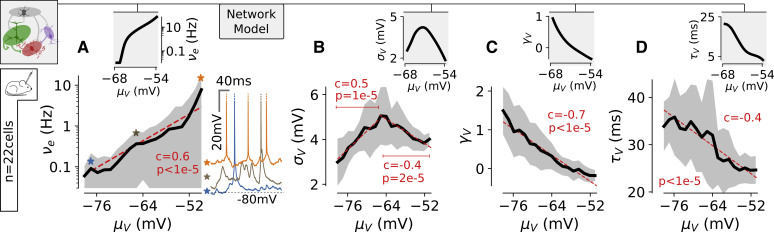
The Model Predicts the Electrophysiological Features Characterizing the Different Non-rhythmic Epochs of Wakefulness in the S1 Cortex(A) Spiking probability (νe, in Hz) of intracellularly recorded layer 2/3 pyramidal cells within μV-classified epochs. The red dashed line is a linear regression between μV and log10(νe) (see STAR Methods). The correlation coefficients and the p value of a one-tailed permutation test (see STAR Methods) are reported. In the right inset, we show 300-ms-long epochs displaying spikes for three levels of μV (blue, brown, and orange stars in main plot). In the top inset, we show the predictions of the network model.(B) Co-modulation between μV and σV. Note that the linear regression has been split into two segments (depicted in red) to test the significance of the non-monotonic relationship.(C) Co-modulation between μV and γV.(D) Co-modulation between μV and τV.See also Figures S6, S7, and S8.